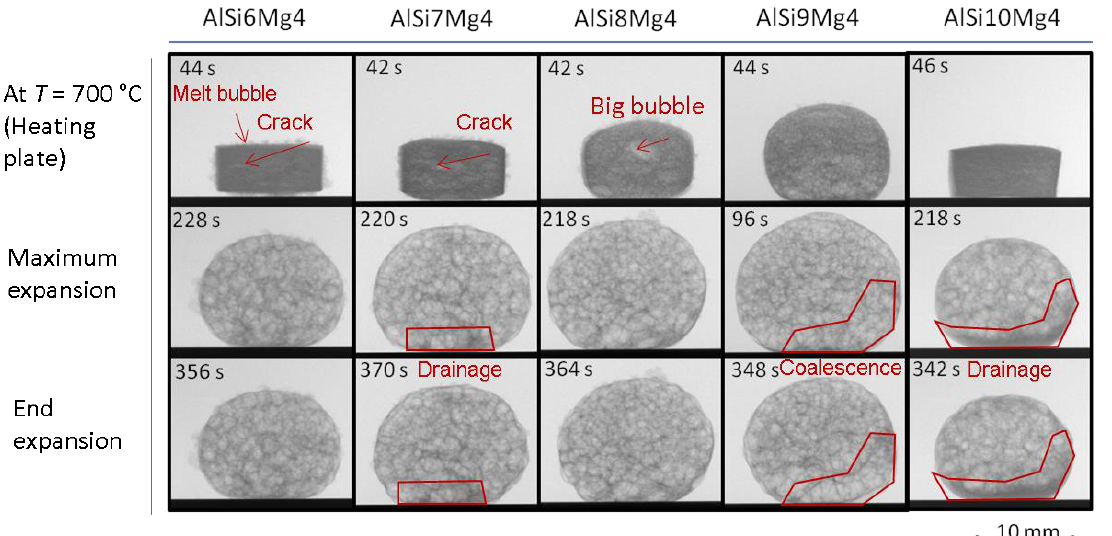
Figure C2. X-ray radiographies of evolving liquid metal foams of compositions AlSi X Mg4 ( X = 6 10 wt.%) extracted from an in situ radioscopic series.